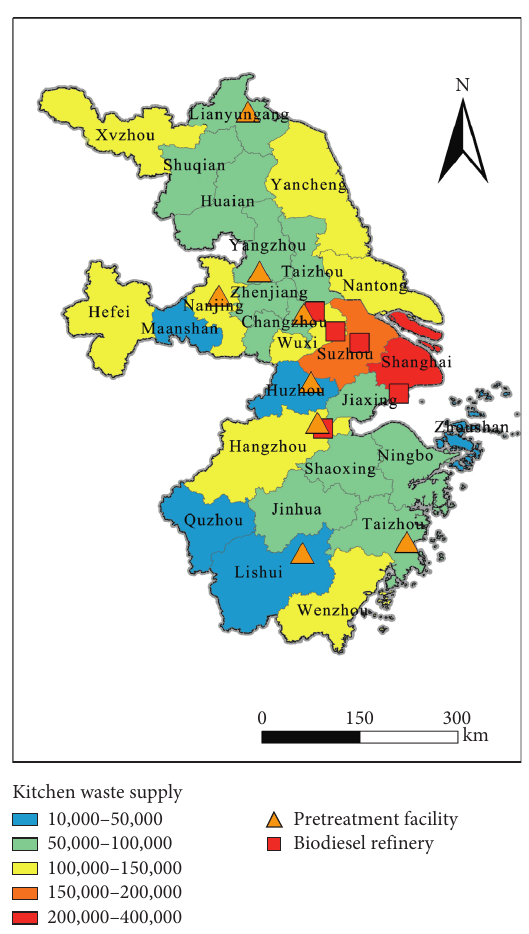
Figure 5: Optimization results of biodiesel supply chain in the collection stage under basic setting scenario.